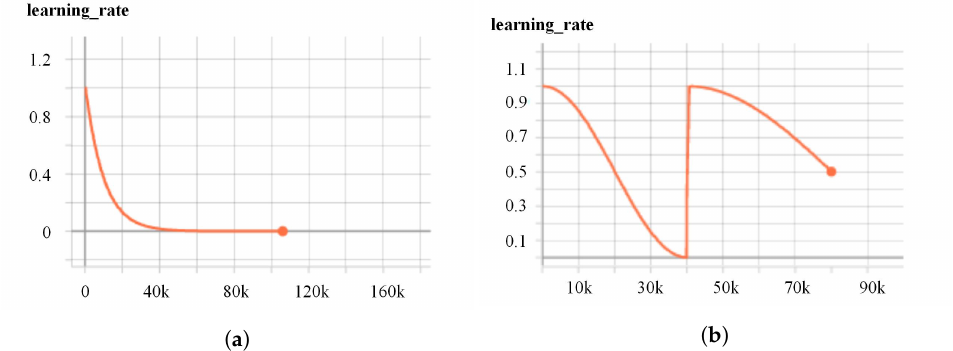
Figure 4. Training of KdO-Net on BundleFusion with different learning rate strategies. ( a ) Learning rate with exponential decay . ( b ) Learning rate with cosine decay restarts